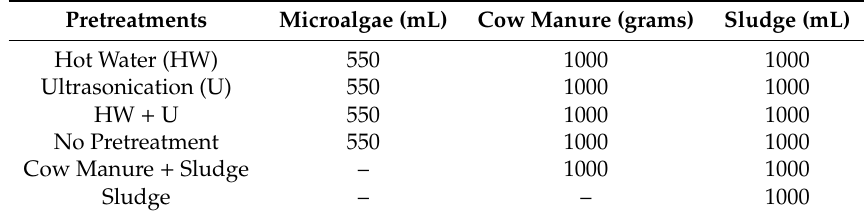
Table 1. Treatments used for the experiment.